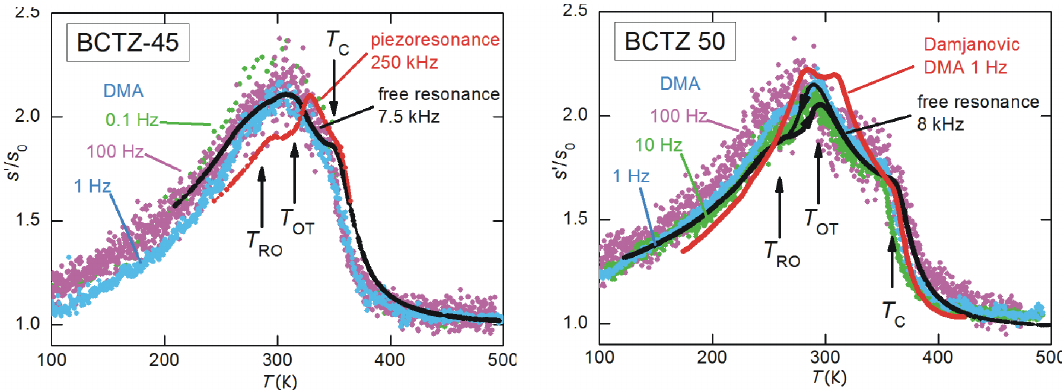
Figure 18. Comparison between the elastic compliances measured in different frequency ranges at two compositions of BCTZ (data from [192]. Also included are the data from DMA of Damjanovic et al. [187] (red curve in